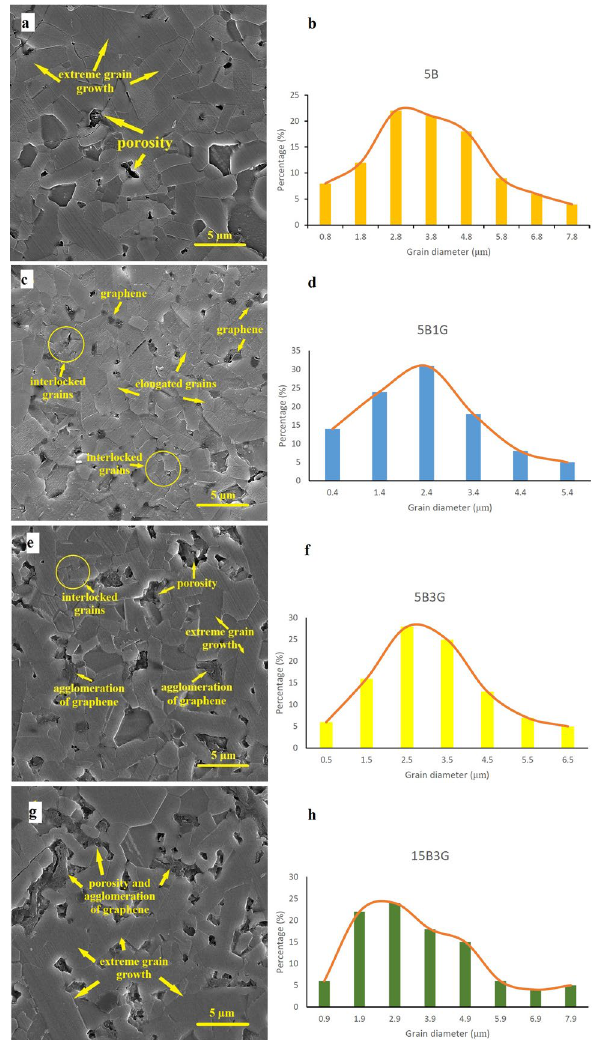
Figure 5. FESEM images of microstructures and grain size distributions of samples ( a , b ) 5B, ( c , d ) 5B1G, ( e , f ) 5B3G and ( g , h )